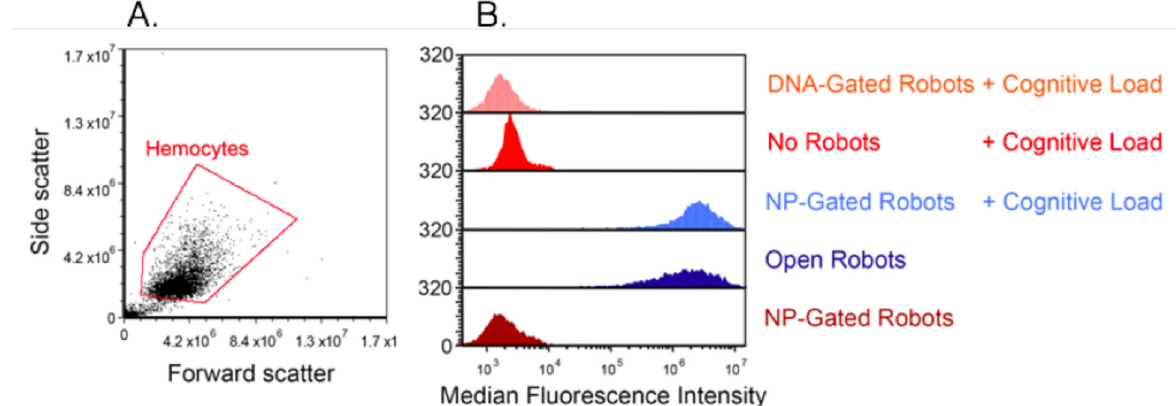
Fig 3. EEG-activated robots engage insect hemocytes in-vivo. (A) physical parameter analysis of B . discoidalis hemocytes following their extraction after each separate experiment. (B) results from five experimental groups: no robots (red), nanoparticle (NP)- gated robots without cognitive load (brown), NP-gated robots with cognitive load (light blue), DNA-gated robots (no NP) with cognitive load (orange), and open robots as a positive control (dark blue).